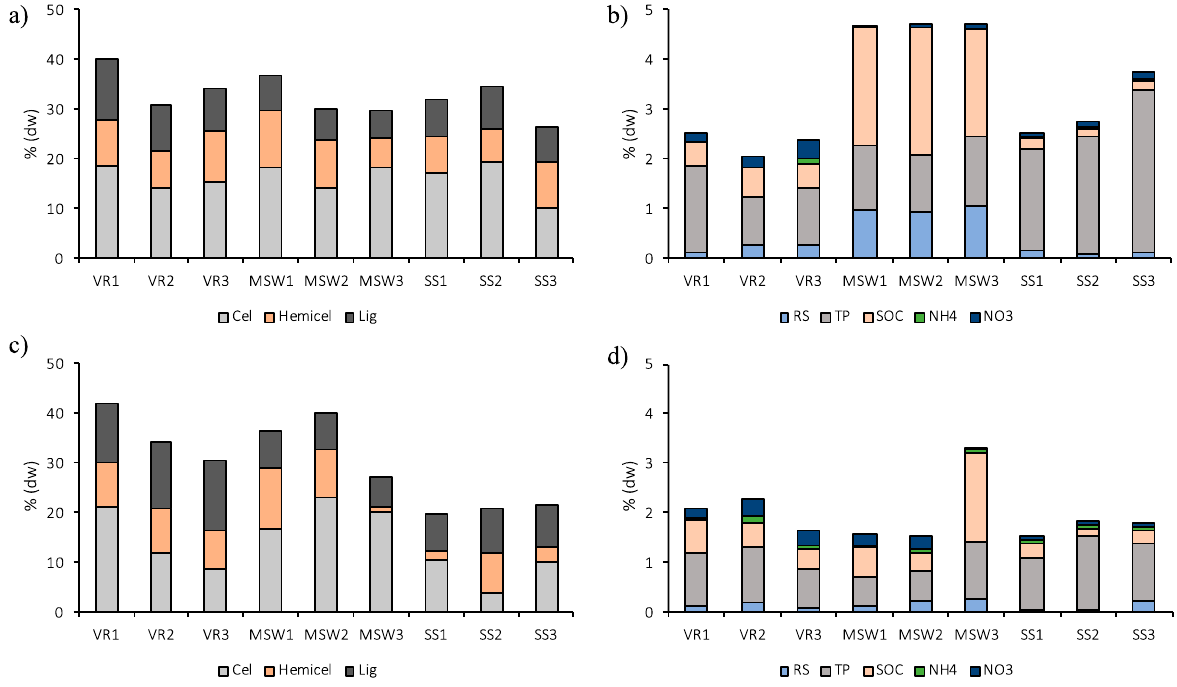
Figure 1. ( a ) Fiber fractions in raw materials; ( b ) soluble fractions in raw materials; ( c ) fiber fractions in compost; ( d ) soluble fractions in compost. Abbreviations: cellulose (Cel), hemicellulose (Hemicel), lignin (Lig), reducing sugars (RS), total proteins (TP), soluble organic carbon (SOC), N-NH 4 + (NH4), N-NO 3 − (NO3).